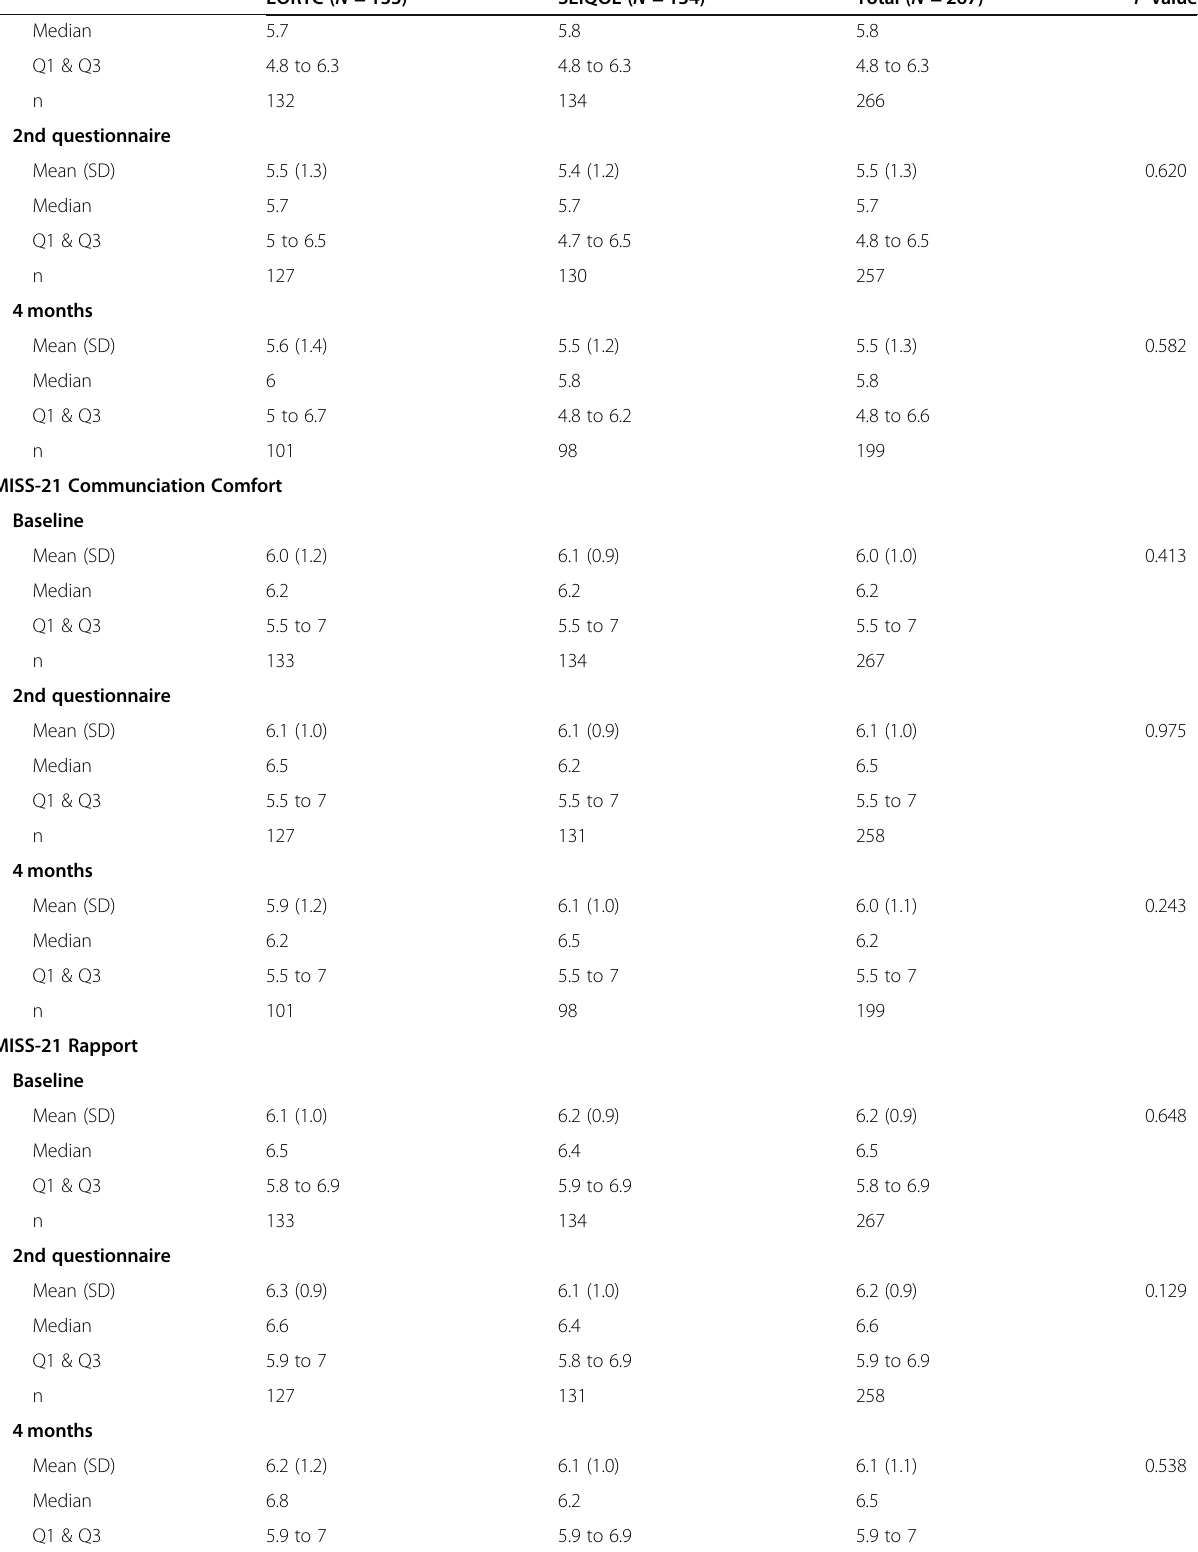
Table 2 Outcomes a over time for analyzed patients